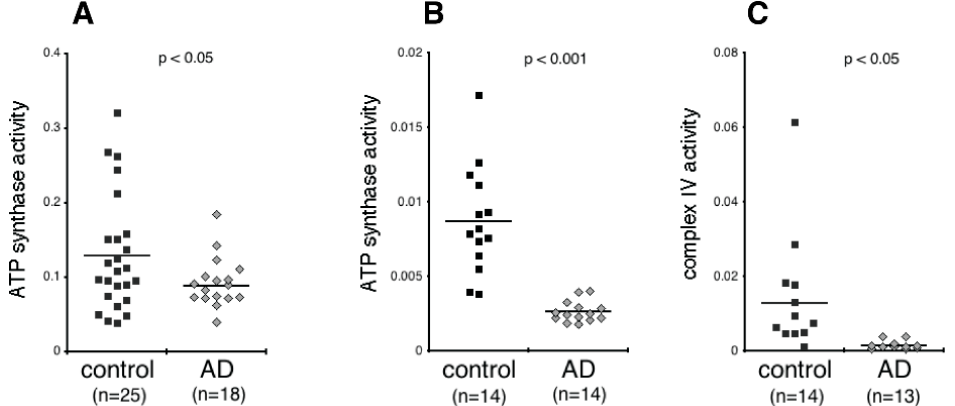
Figure 3. Activity of the mitochondrial oxidative phosphorylation proteins in plasma NDEVs of control and AD. Each data point represents the value for one study participant. ( A ), cohort 1; ( B , C ), cohort 2. The numbers of study participants are indicted on the graphs. The mean ± S.E.M. of control and AD groups, respectively, was 0.129 ± 0.015 and 0.088 ± 0.009, p < 0.05, for ATP synthase, cohort 1 ( A ); 0.009 ± 0.001 and 0.003 ± 0.0002, p < 0.001, for ATP synthase, cohort 2 ( B ); 0.013 ± 0.004 and 0.001 ± 0.0003, p < 0.05, for complex IV ( C ). Values in ( A ) were normalized for content of the EV marker CD81. Values in ( B , C ) were normalized for quantity of the respective protein that was determined within the same assay (see Methods). Statistical significance of differences in values between control and AD groups were calculated by two sample t tests.